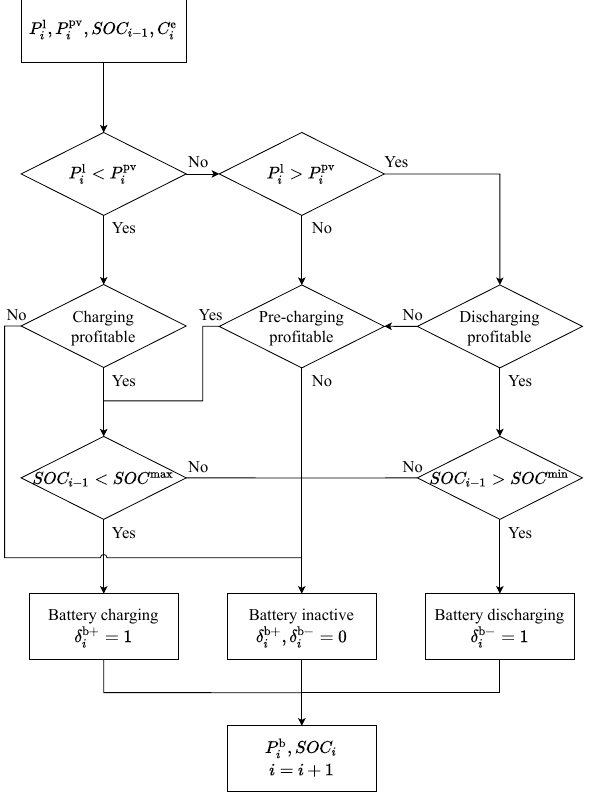
Figure 11. Cost-efficient battery operation